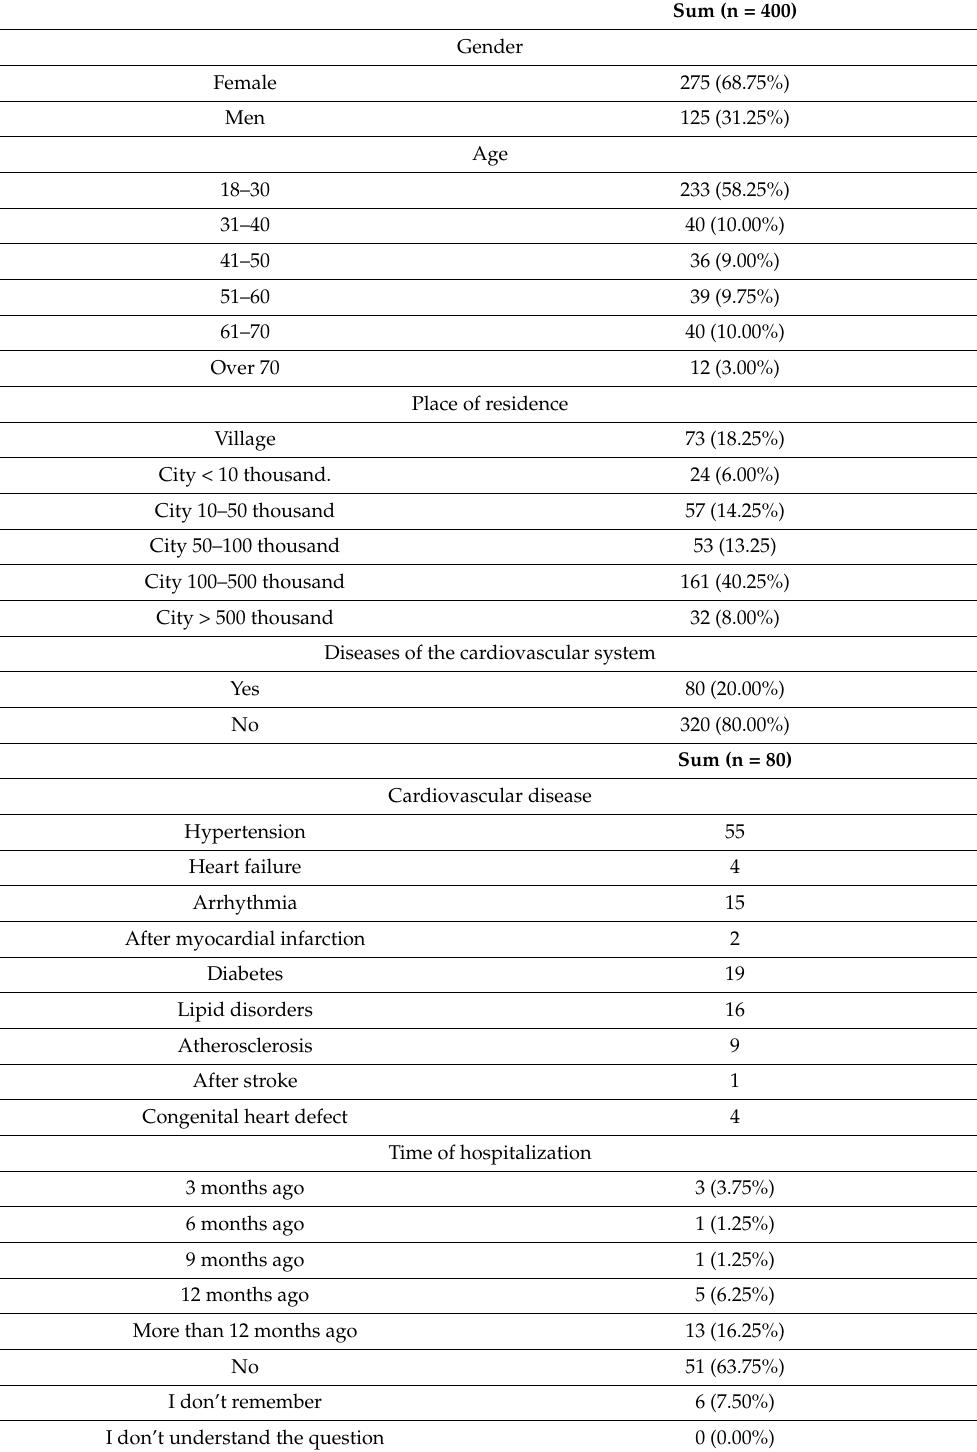
Table 1. Characteristics of the study